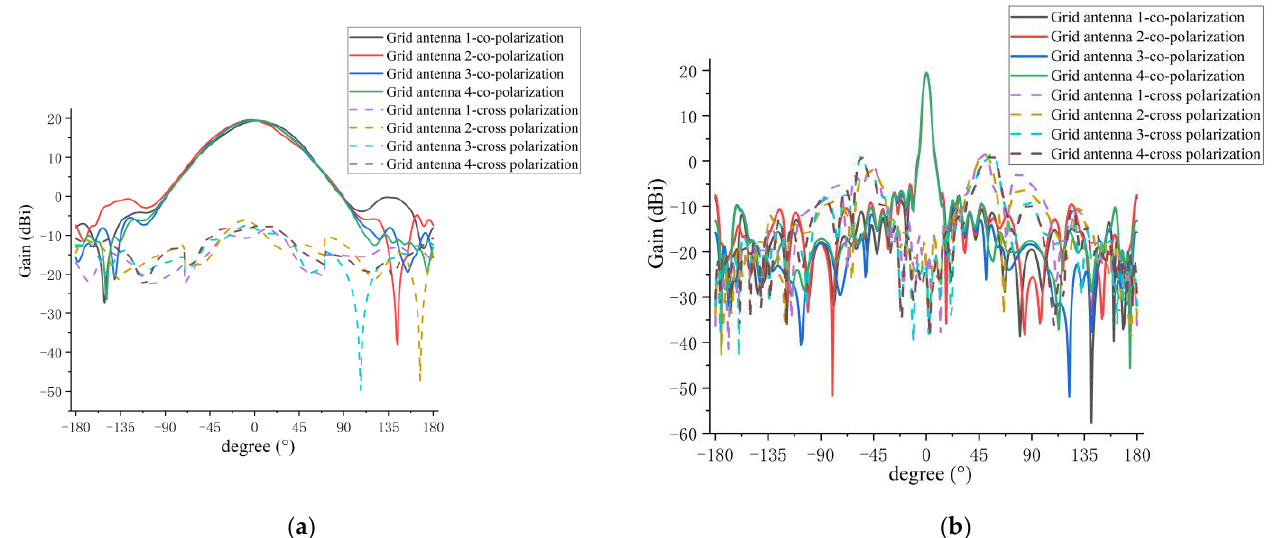
Figure 10. Simulated amplitude patterns for every antenna element in sparse array: ( a ) E-plane patterns; ( b ) H-plane patterns.